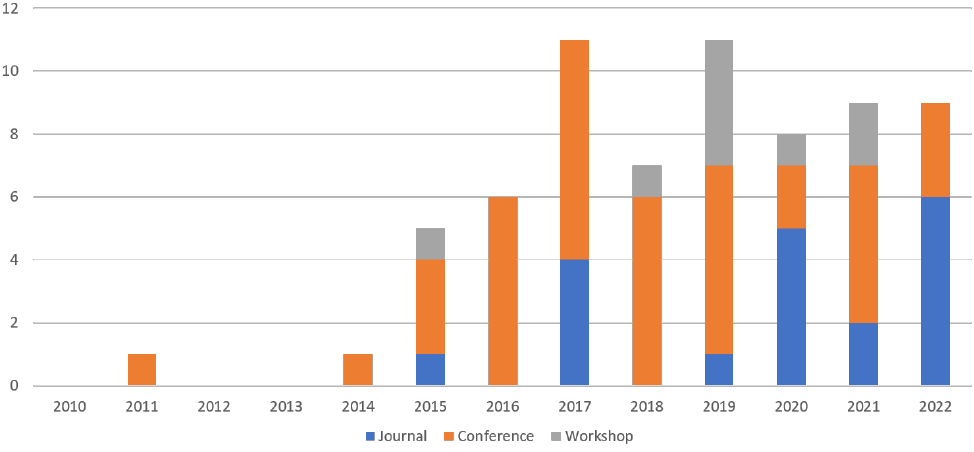
Figure 3. Distribution of papers by year and publication type.